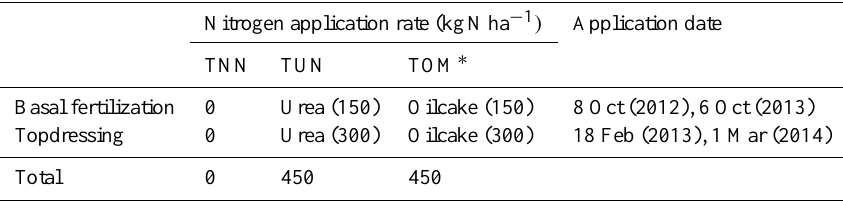
Table 1. Field management of synthetic and organic nitrogen fertilizers for tea plantations under different treatments during the period of